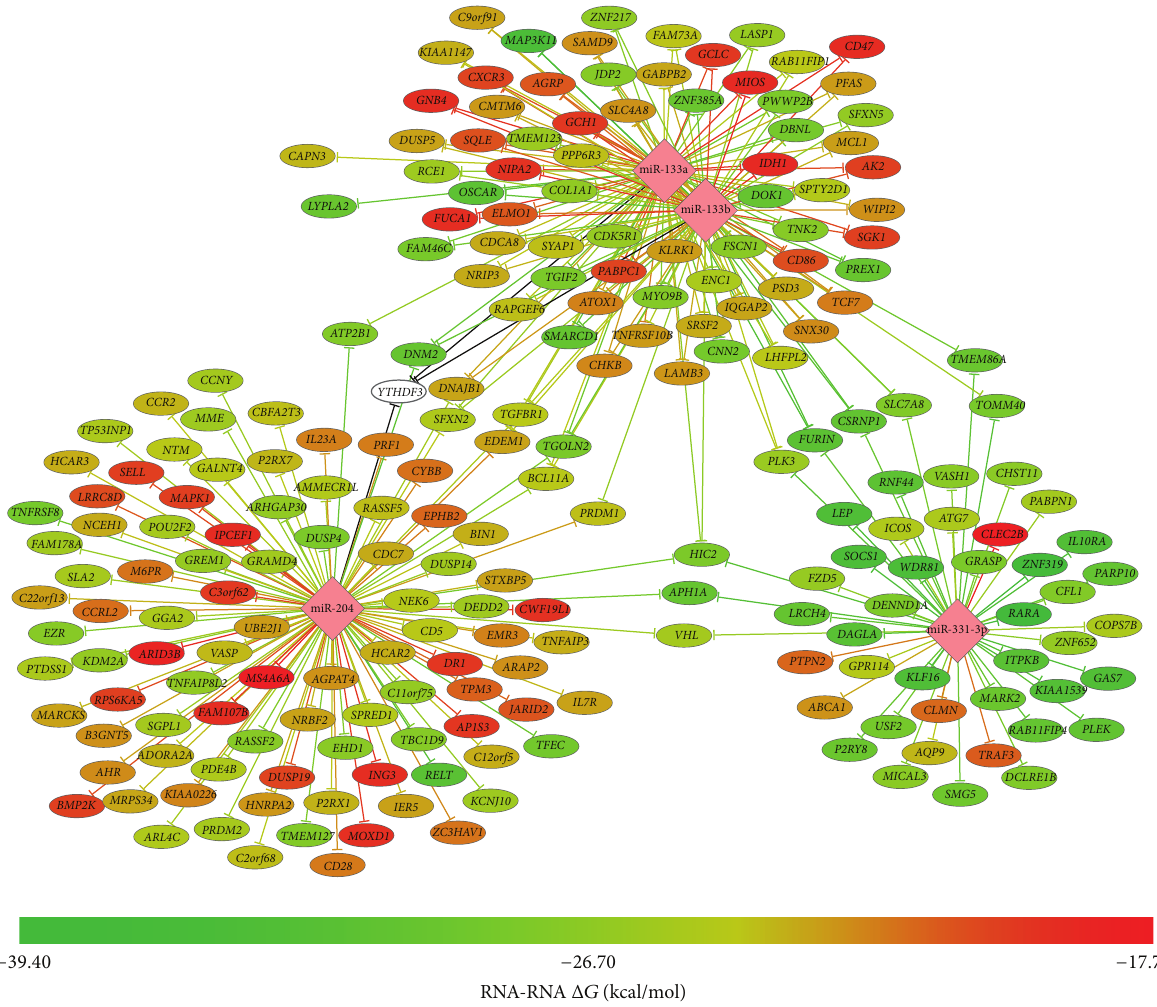
Figure 5: A Network of miRNAs, miR-133a, miR-133b, miR-331-3p, and miR-204, and their target genes. Each miRNA is predicted to regulate a large number of target genes (mRNAs). Bioinformatic analysis predicted that 222 genes with upregulated expression in AAA based on a prior microarray study [81] were targets of miR-133a, miR-133b, miR-331, or miR-204. The predicted minimum free energy of the miRNA and target mRNA hybridization from the program RNAhybrid version 2.1.is shown by the line and node color. Black lines for YTHFD3 indicate that the 3 󸀠 UTR sequence was not available from Ensembl BioMart, and the minimum free energy was not calculated. miR-30c-2 ∗ was not included because it is a miRNA ∗ strand that is usually degraded and therefore nonfunctional. The figure is reproduced from